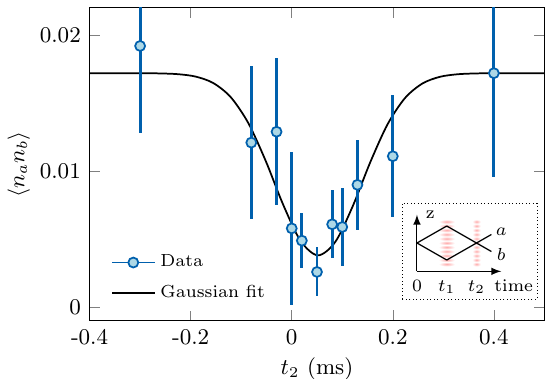
Figure 4: The cross correlation between the two output modes a and b as a function = 0 is arbitrary). The line of the time t of the beam splitter (the position of t 2 2 shows a fit to a Gaussian function. The fitted visibility is 0.78(6) and the RMS width is 86(15) µ s. The error bars on the data points denote the statistical uncertainty (standard deviation) estimated with the bootstrapping method. The inset shows our HOM interferometer in the center-of-mass frame of the atom pair. Laser standing waves act as deflectors and beam splitters and the outputs a and b correspond to small regions at the